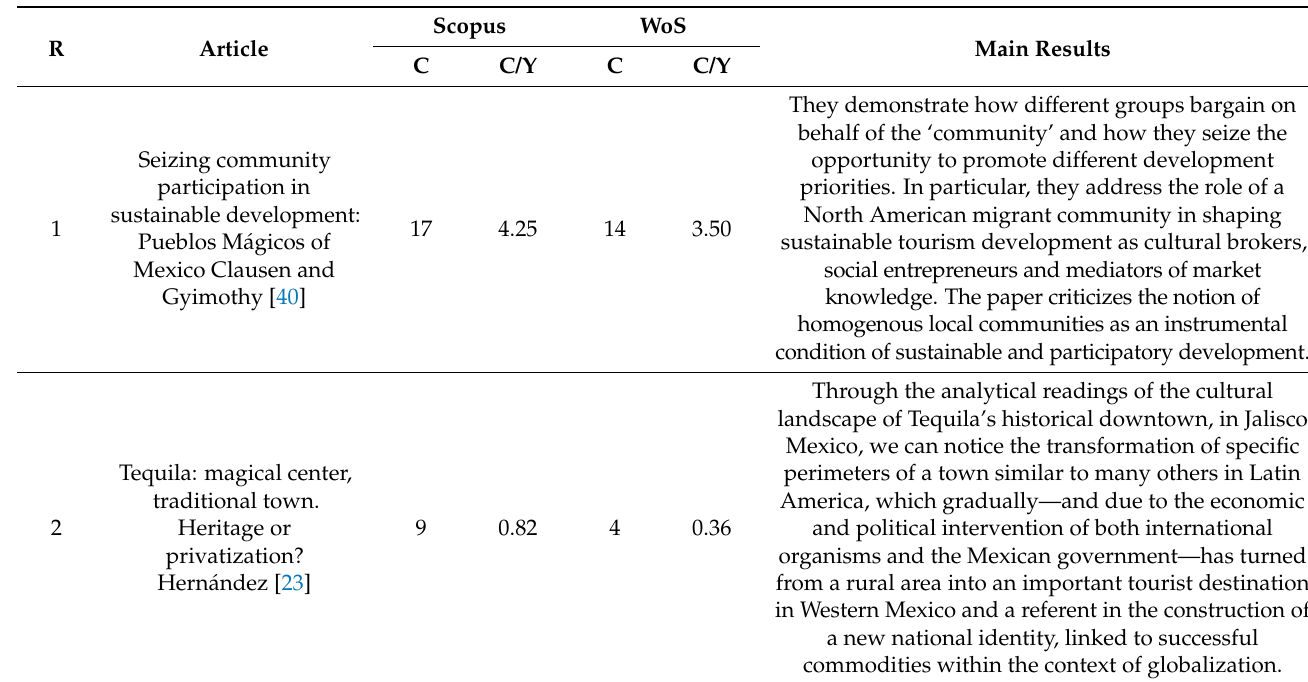
Table 3. Ranking of the most cited articles on “Pueblos M á